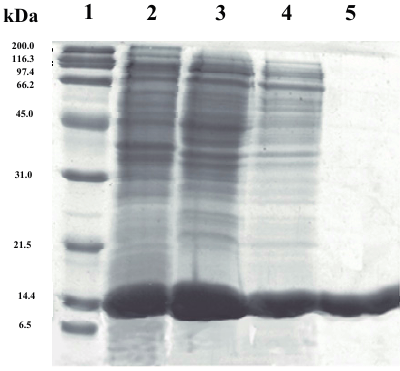
Figure 1. SDS-PAGE of different purification steps of Bp NDT produced by E. coli BL21 (DE3). Lane 1 , broad range molecular weight standards from BioRad. Lane 2 , 30 μ g of protein after sonication. Lane 3 , 30 μ g of protein after anionic exchange chromatography on Bio-Scale Mini UNOsphere Q cartridge. Lane 4 , 10 μ g of protein after size-exclusion